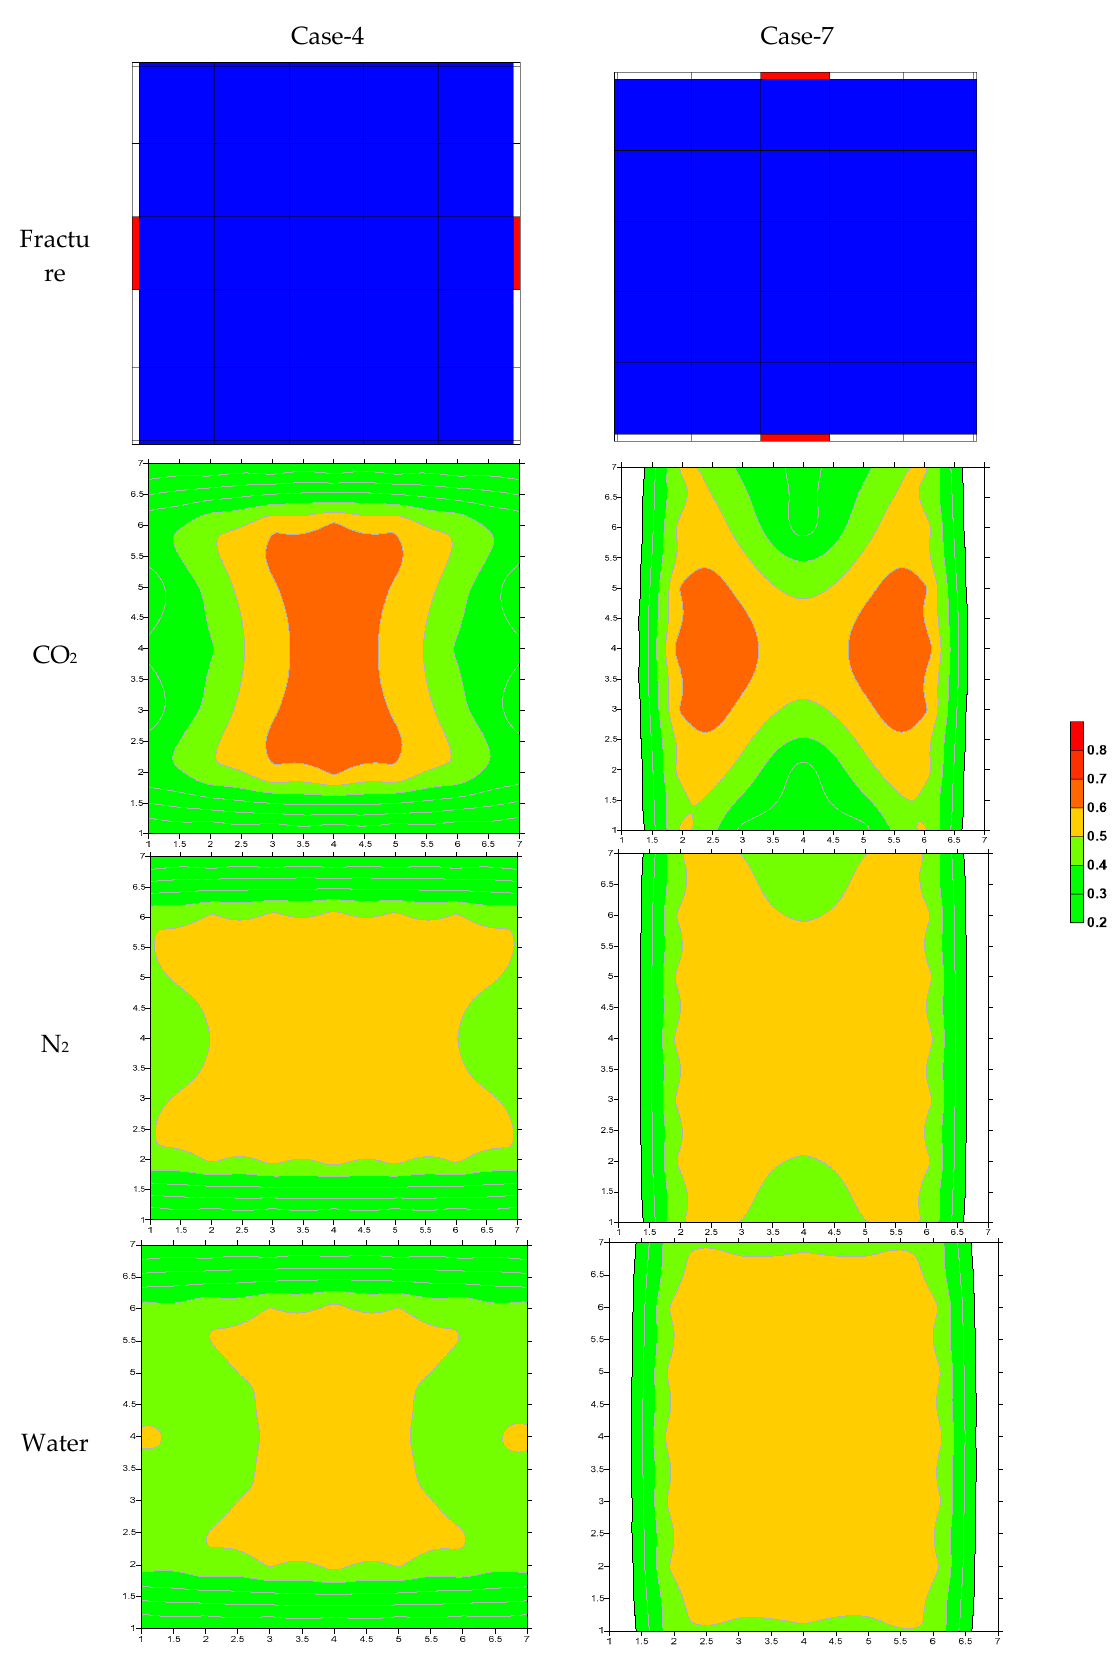
Figure 31. Oil saturation of different fluids in production process.